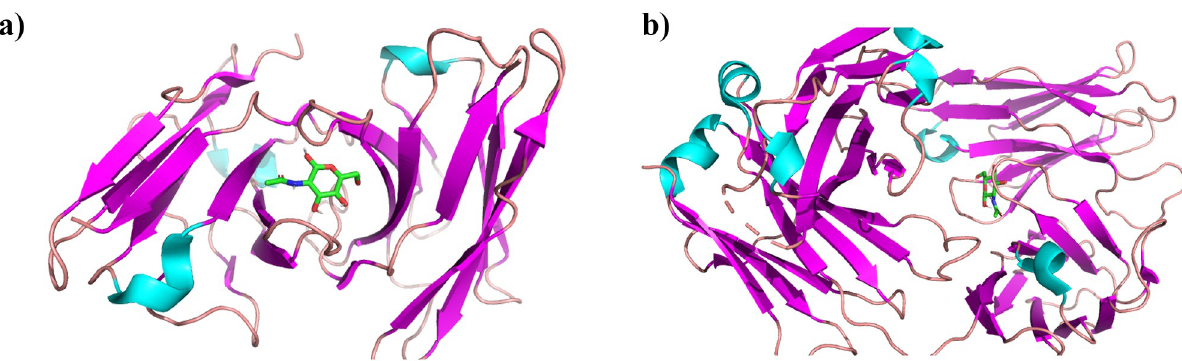
Fig 7. Top docked poses of D-GlcNAc with (a) S2H13 neutralizing antibody Fab fragment from PDB 7JV2 and (b) STAU-281 Fab anti- Staphylococcus aureus antibody from PDB 6P9H. All images generated by PyMol, antibody structure represented as cartoons and colored by their secondary structure whereas D-GlcNAc is represented with sticks and colored by element (green).